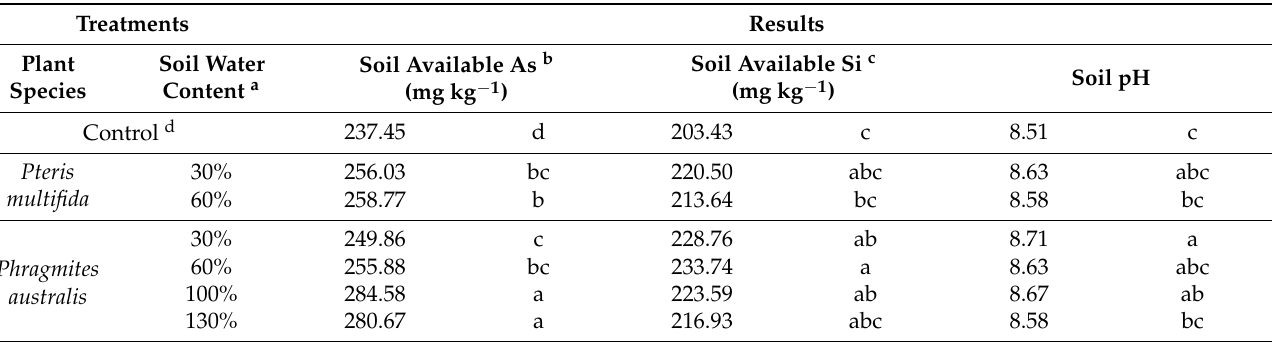
Table 1. Soil As, Si concentration and pH *,